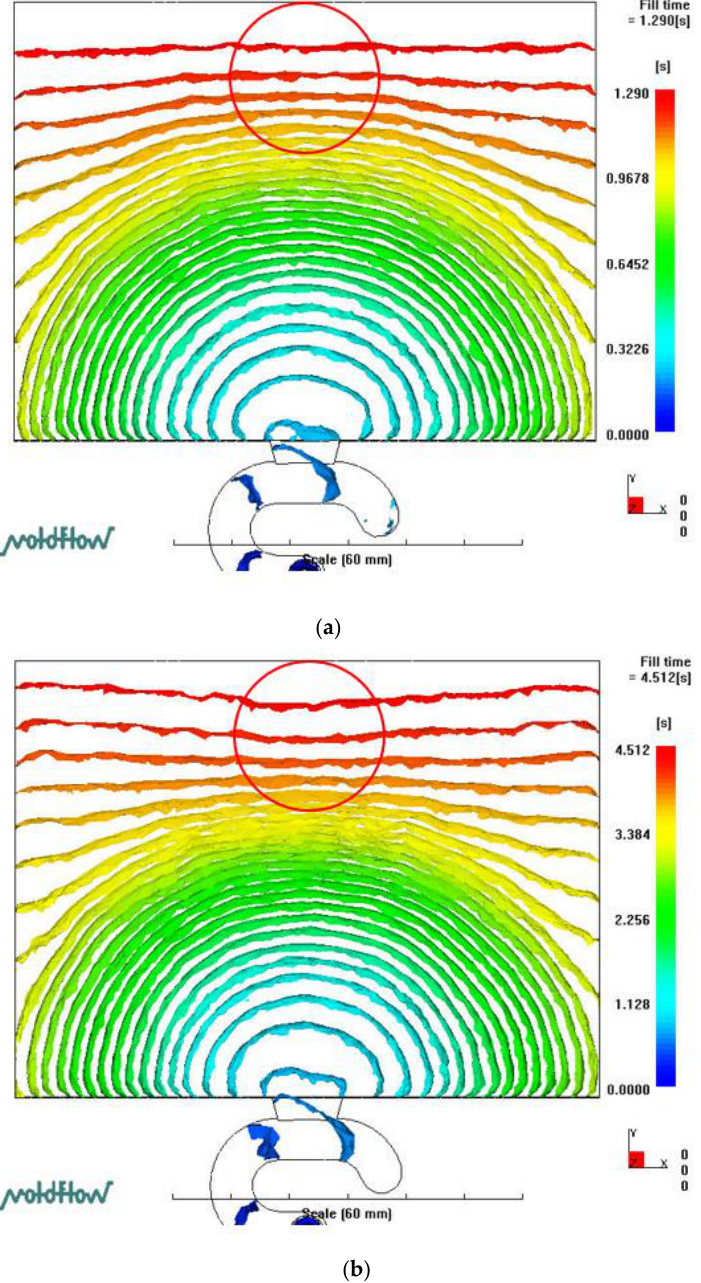
Figure 6. Melt front situation for different injection speeds. ( a ) Melt front uniformity. Mold temp: 60 °C, Melt temp: 245 °C , Injection speed 10 cm/s. ( b ) Melt front hysteresis. Mold temp: 60 °C , Melt temp: 245 °C , Injection speed 3 cm/s.